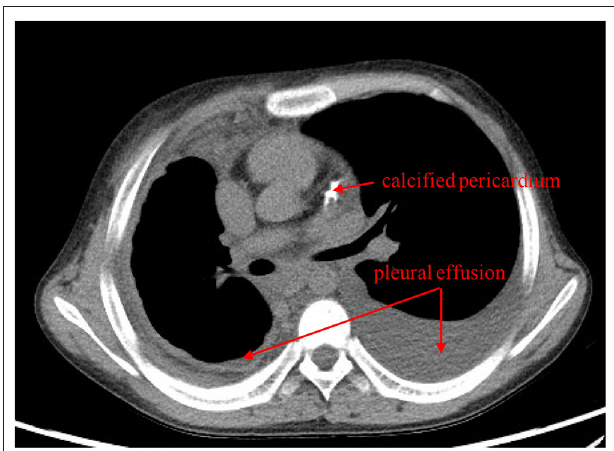
FIGURE 1 | Cardiac computed tomography shows bilateral pleural effusion and a calcified pericardium (red